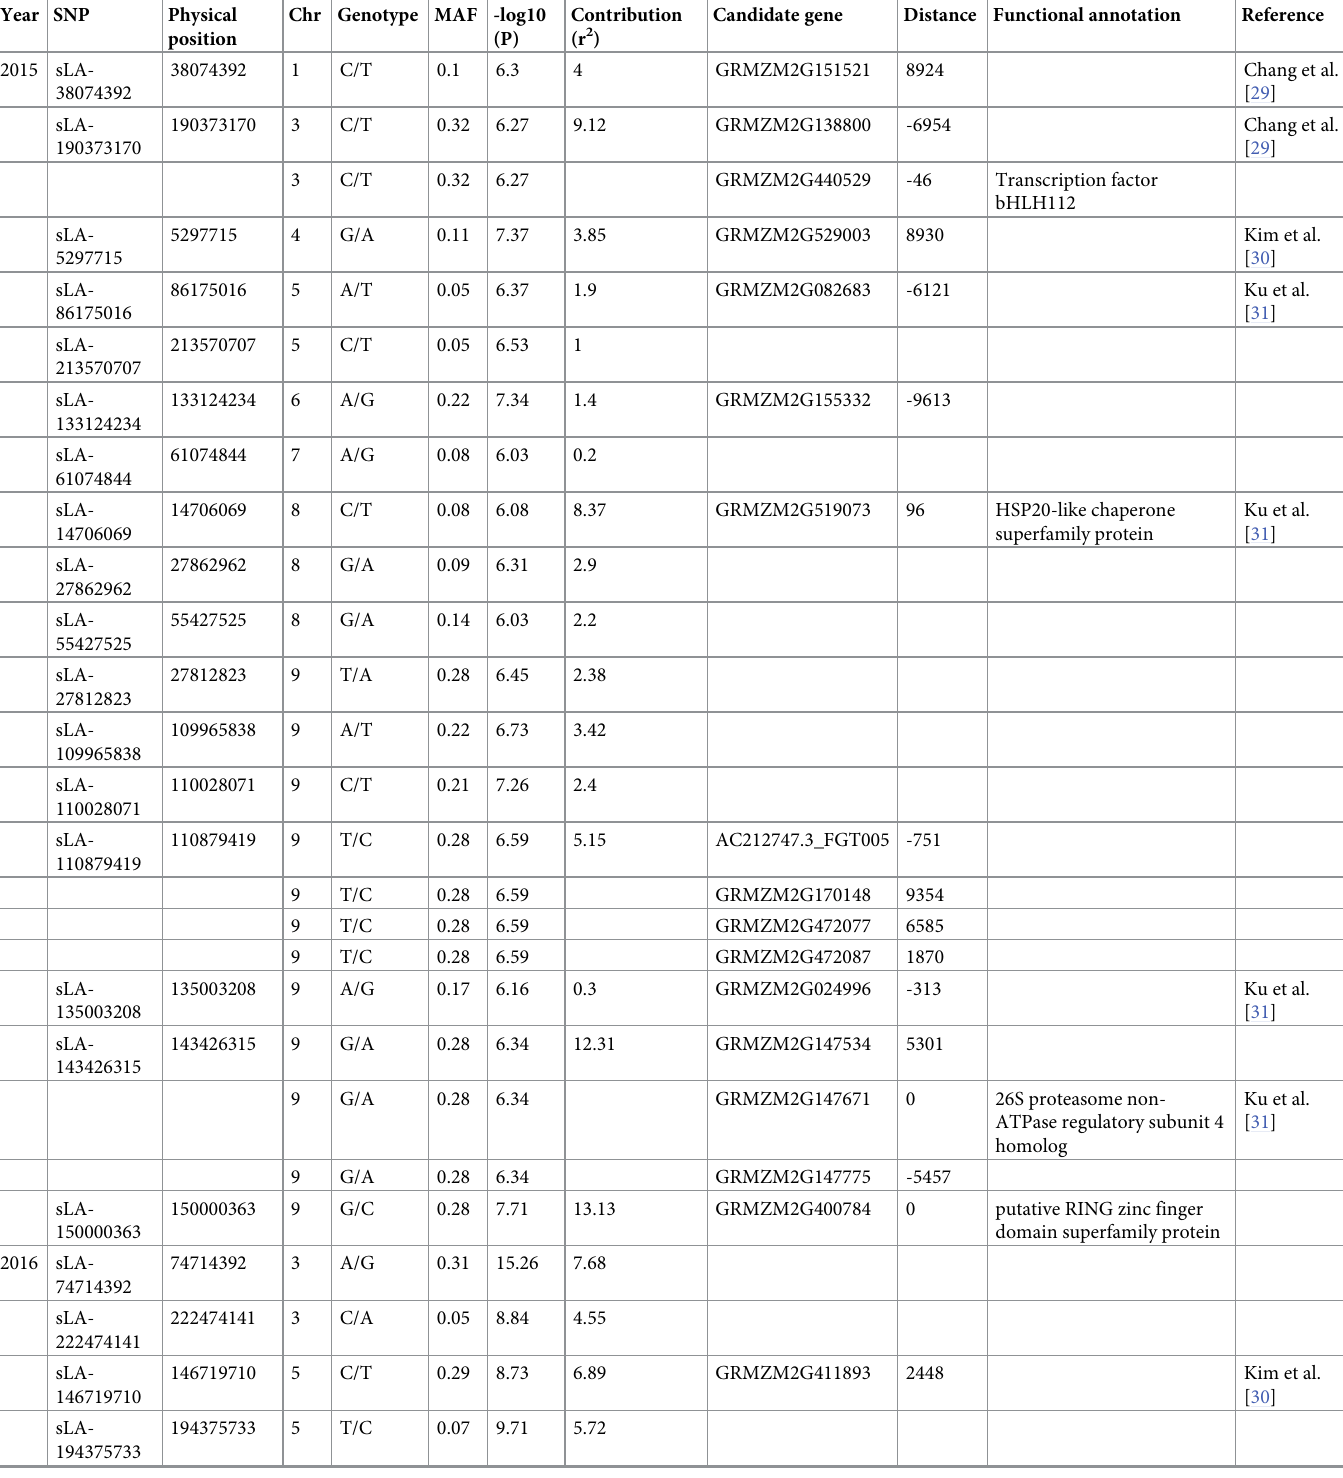
Table 1. Significant SNPS and candidate genes associated with leaf angle between 2015 and